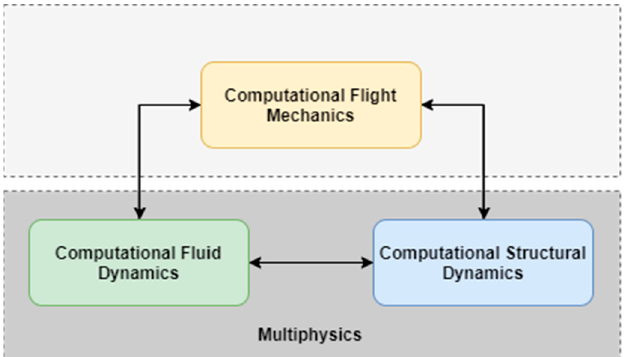
Figure 1. Governing subsystem